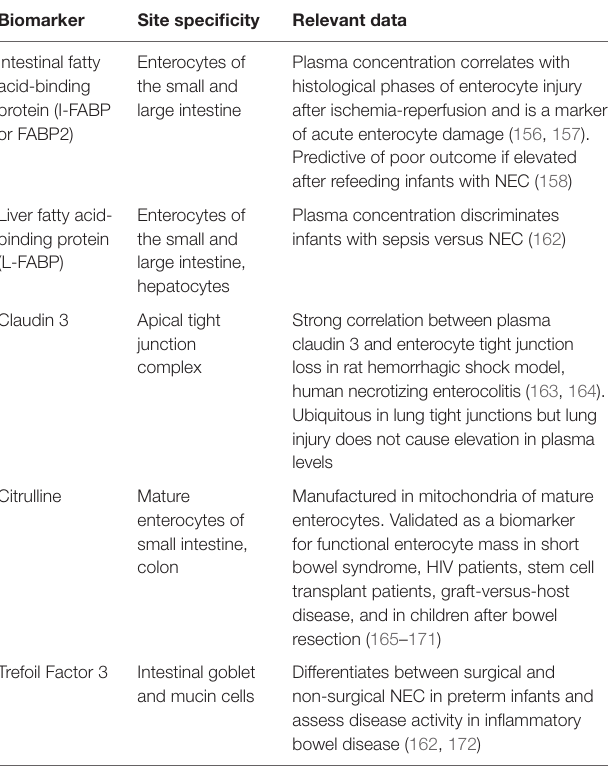
TABLe 3 | Minimally invasive plasma biomarker candidates to assess intestinal barrier function.